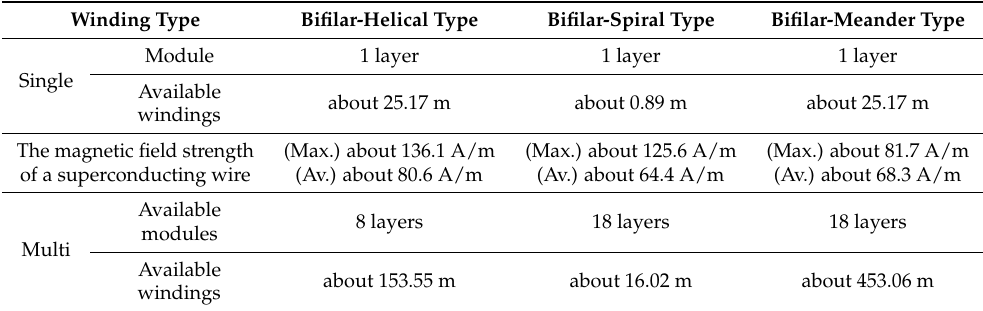
Table 1. Superconducting wire usage and force of the magnetic field strength according to each winding